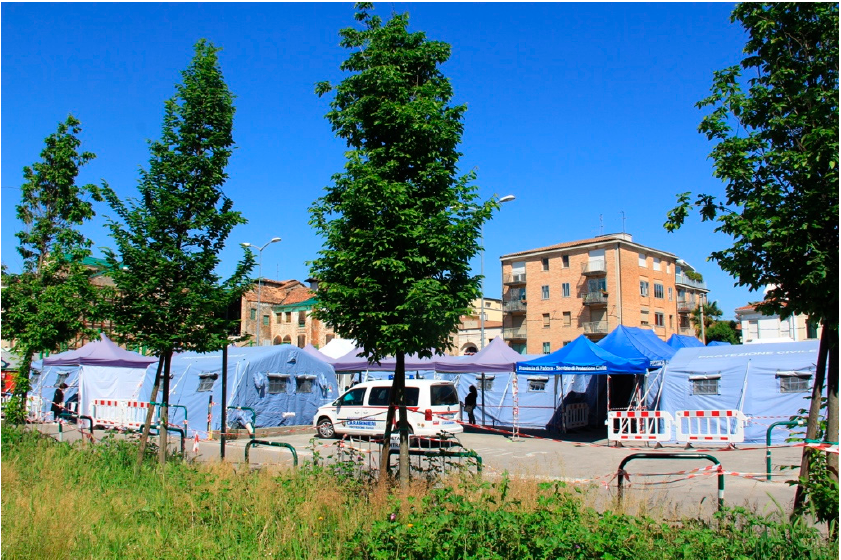
Figure 1. The Advanced Triage of the Infectious Diseases Unit, Padua University Hospital. (Reproduced with permission from Azienda Ospedale Università di Padova).